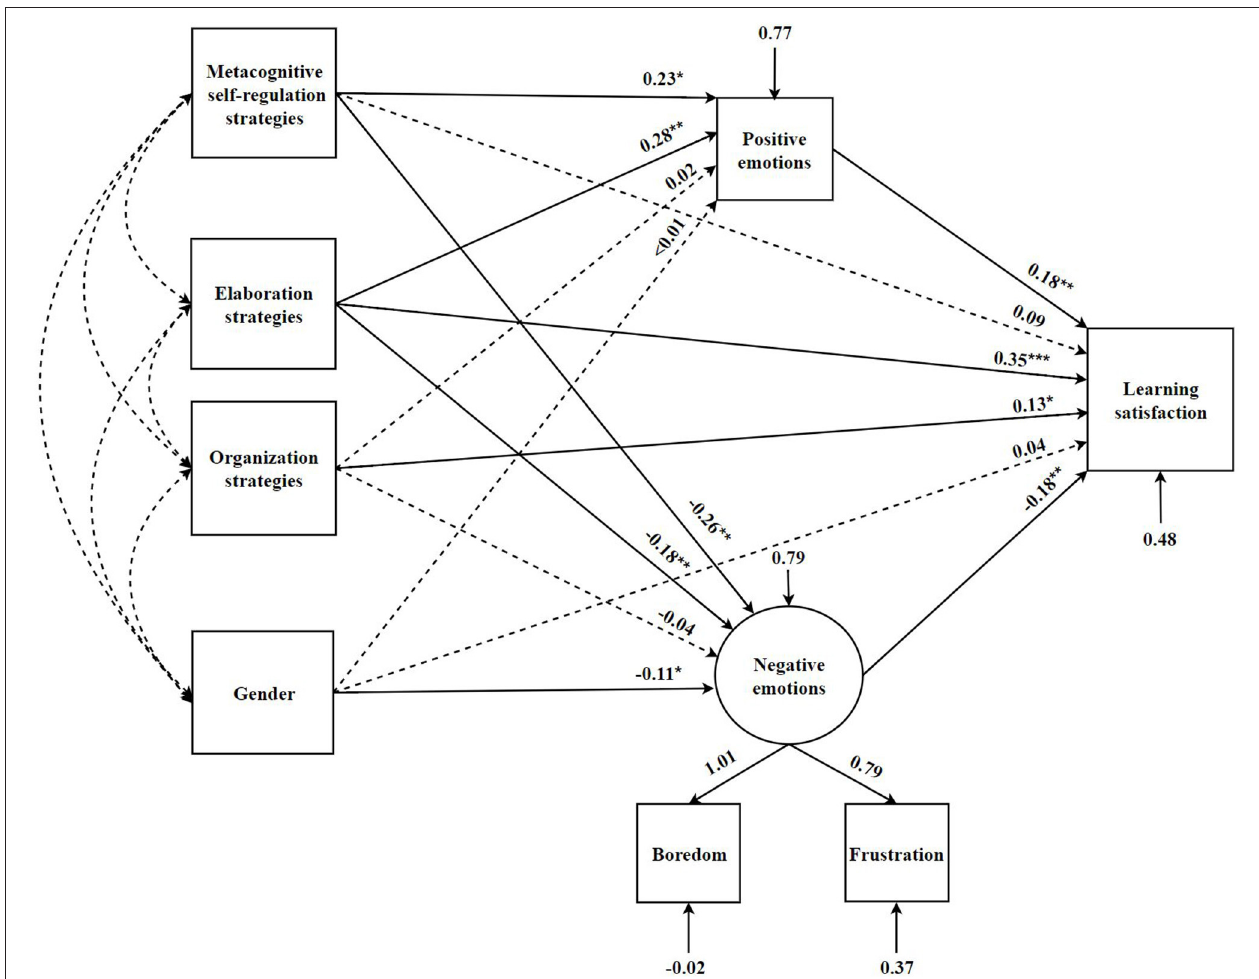
FIGURE 2 | The influence of learning strategies on learning satisfaction: a mediating model of academic emotions. * p < 0.05, ** p < 0.01, *** p < 0.001.